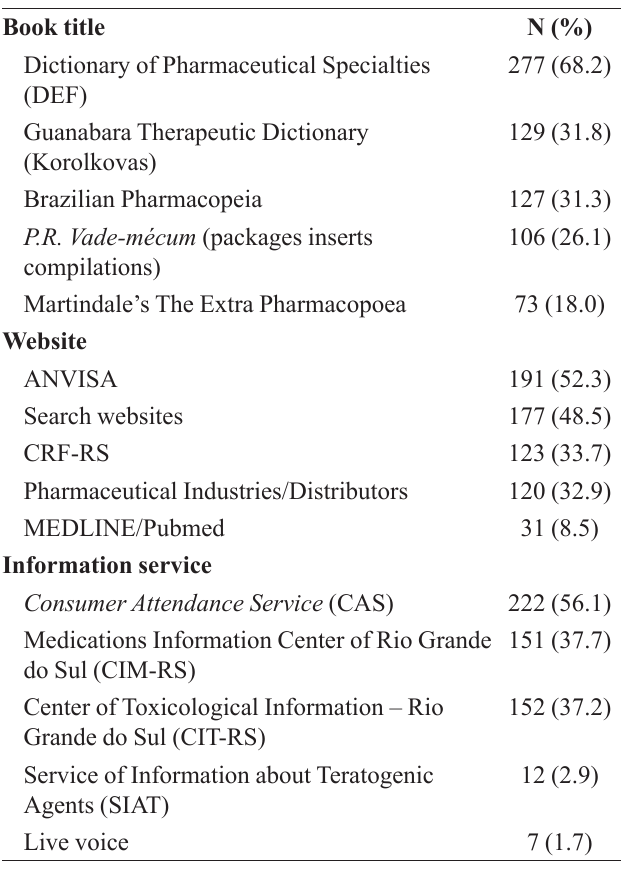
TABLE III – Availability and utilization of information sources